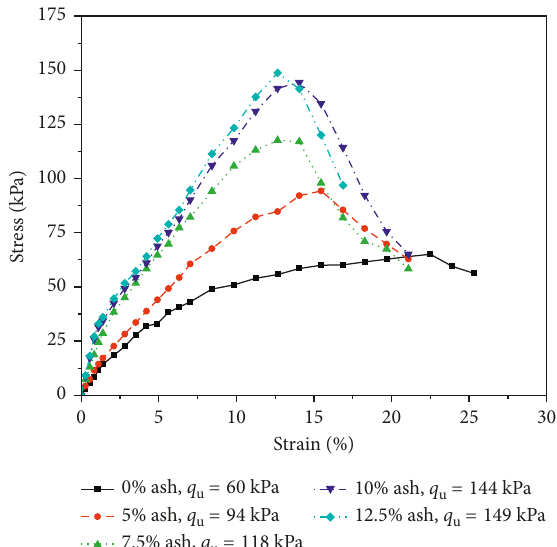
Figure 4: Stress-strain graphs from the UCS tests.